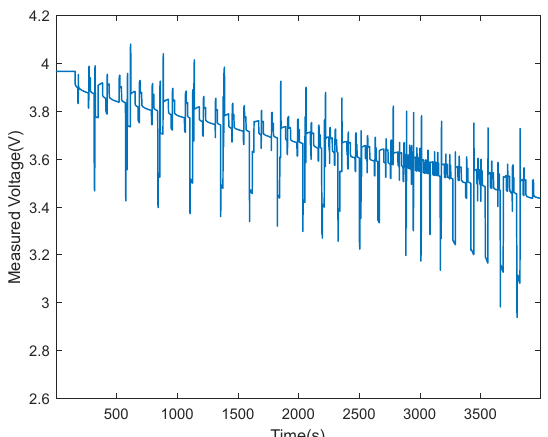
Figure 15. Measured current during dynamic current.